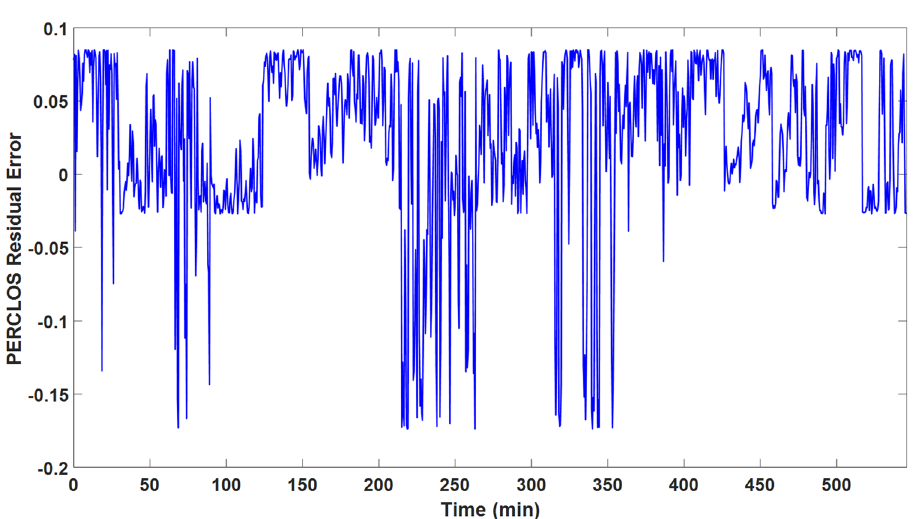
Figure 6. The PERCLOS residual error of the LS method to identify the parameters of the state transition equation. The root mean squares error (RMSE) between actual PERCLOS and modeled PERCLOS by state transition equation is 0.061. This error is higher in some parts of the data which are corresponding to either extremely low (alert) or extremely high PERCLOS (very drowsy) which are not of interest of this method